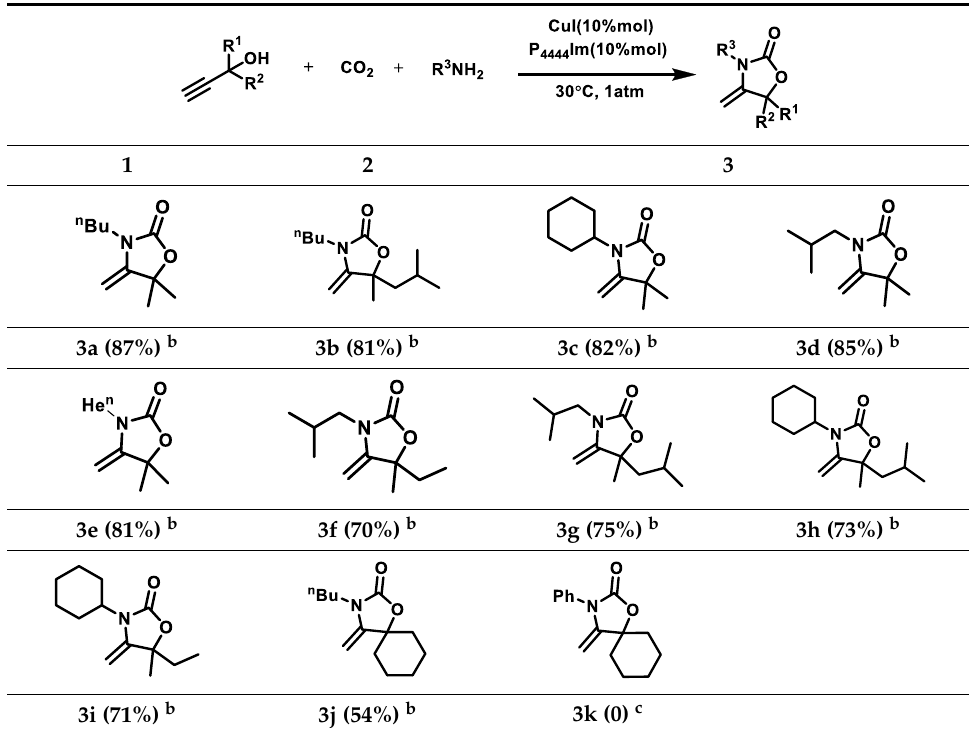
Figure 2. Effect of reaction time on the product yield over CuI and [P4444][Im]; Reaction conditions: 1a , 1.0 mmol, 2a , 1.0 mmol, CuI, 0. mmo, [P4444][Im], 0.1 mmol, CO 2 (1 atm), 30 °C. The yield was isolated yield. Table 2. Three-component reactions of propargylic alcohols ( 1 ), amines ( 2 ) and CO 2 under optimized conditions a .